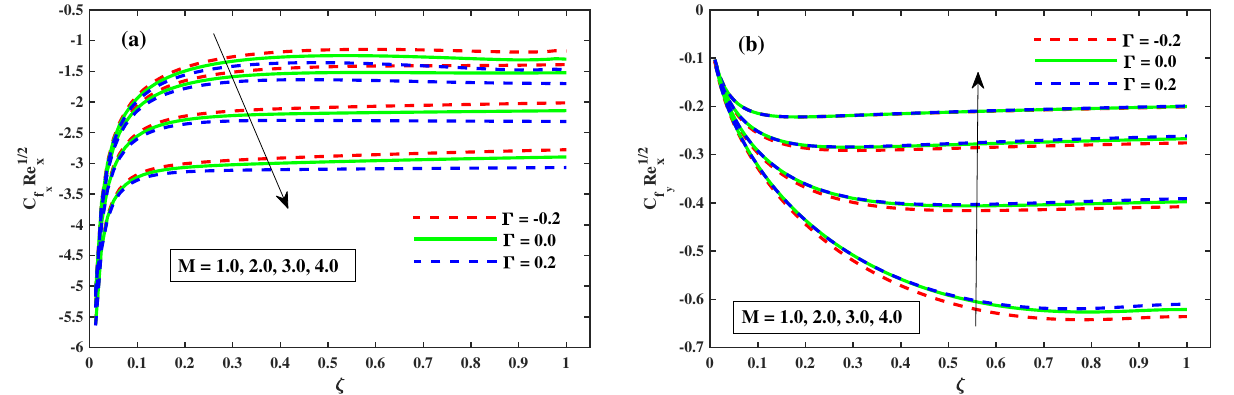
Figure 6. Influence of M on Cf x Re 1/2 x along x-direction in ( a ), and Cf y Re 1/2 y along y-direction in ( b ).